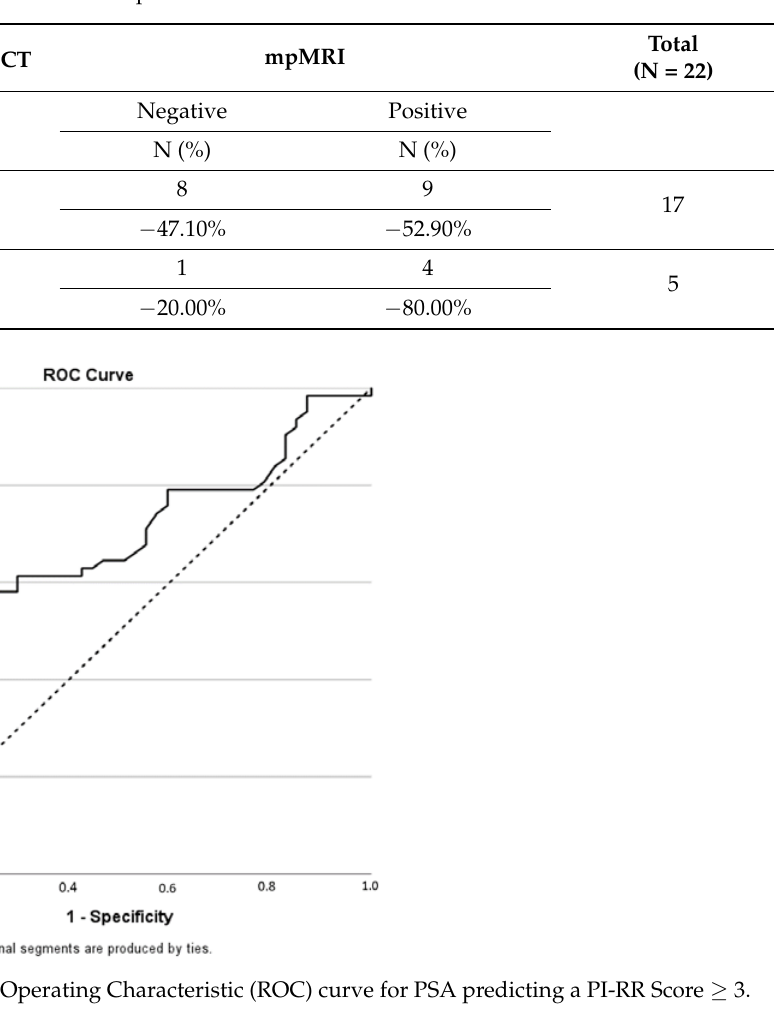
The best cutoff to predict mpMRI positive results was 0.60 ng/mL (AUC = 0.665, 95%CI = 0.561–0.768, p = 0.003, sensitivity = 54.8%, specificity = 85.1%, PPV = 82.9%, NPV